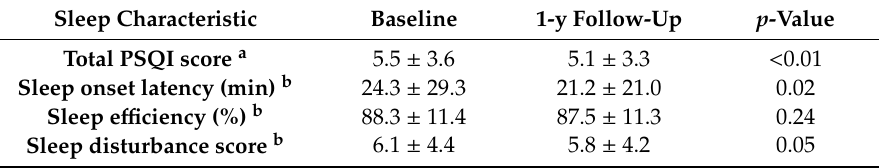
Table 2. Measures of sleep of the analytic sample at baseline and 1-y